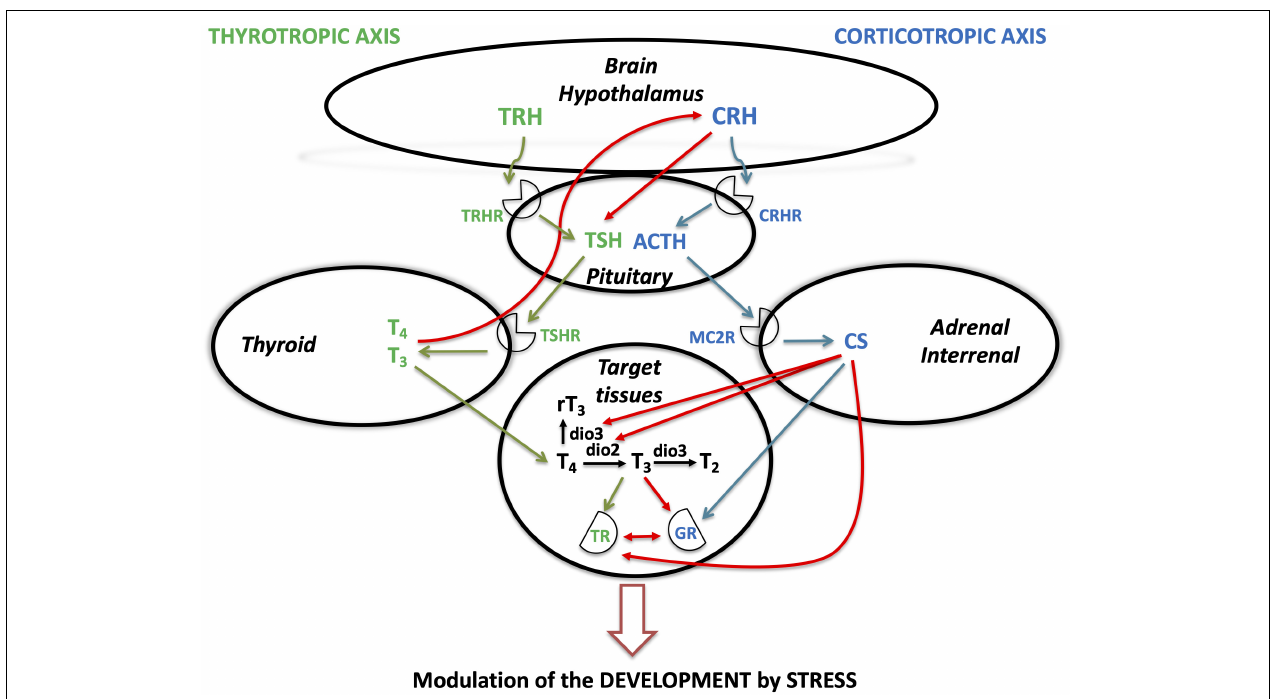
FIGURE 4 | Interactions between thyrotropic and corticotropic axes during vertebrate developmental transitions. The figure illustrates current knowledge on the interactions between the thyrotropic (HPT) and corticotropic (HPA/HPI) axes, during various developmental transitions (amphibian and teleost metamorphoses, sauropsid egg hatching and mammalian birth). ACTH, adrenocorticotropin; CRH, corticotropin-releasing hormone; CRHR, corticotropin-releasing hormone receptor; CS, corticosteroids; dio, deiodinase; GR, glucocorticoid receptor; MC2R, melanocortin receptor 2; MR, mineralocorticoid receptor; T 4 , thyroxine; T 3 ,